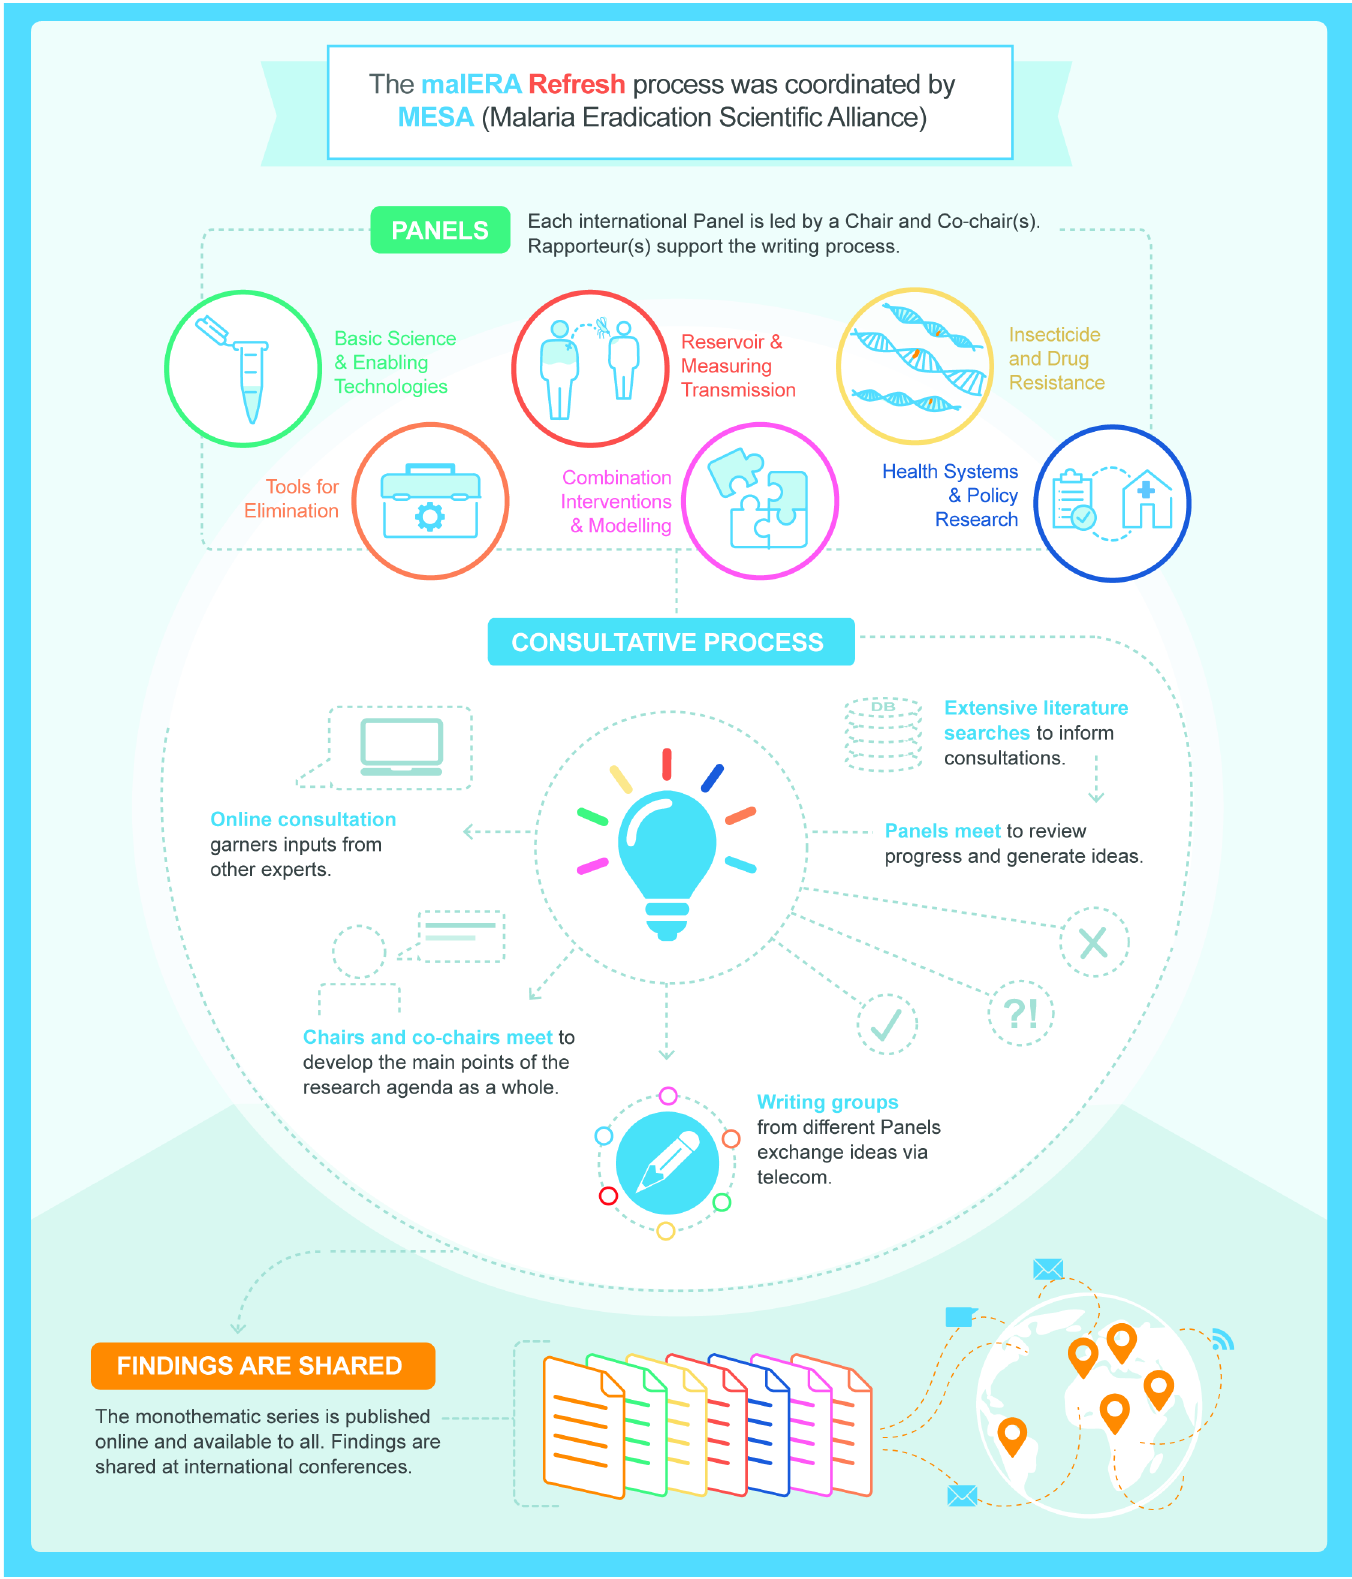
Fig 3. malERA Refreshprocess. malERA, Malaria EradicationResearch Agenda; MESA, MalariaEradicationScientific Alliance.